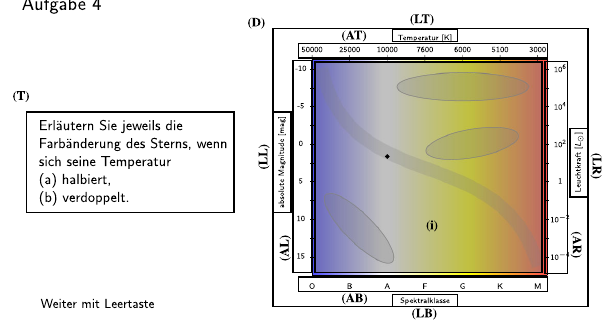
FIG. 4. Definition of areas of interest (AOIs) for all items as originally used in the study (English translations can be found in the Supplemental Material [51]). Two global AOIs cover the text (T) and the diagram (D). The D-AOI includes nine smaller, local AOIs, namely, the interior of the diagram (i) and each axis (AL, AR, AT, AB) and axis label (LL, LR, LT, LB) in the left, right, top, and